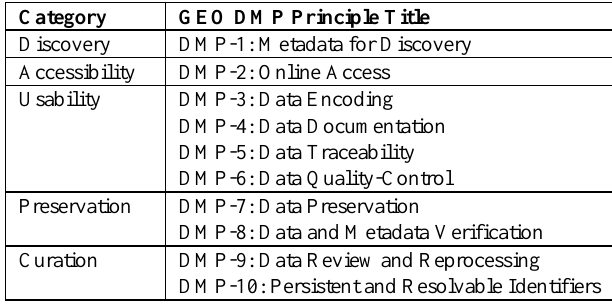
Table 1. Topics and Titles of GEO Data Management